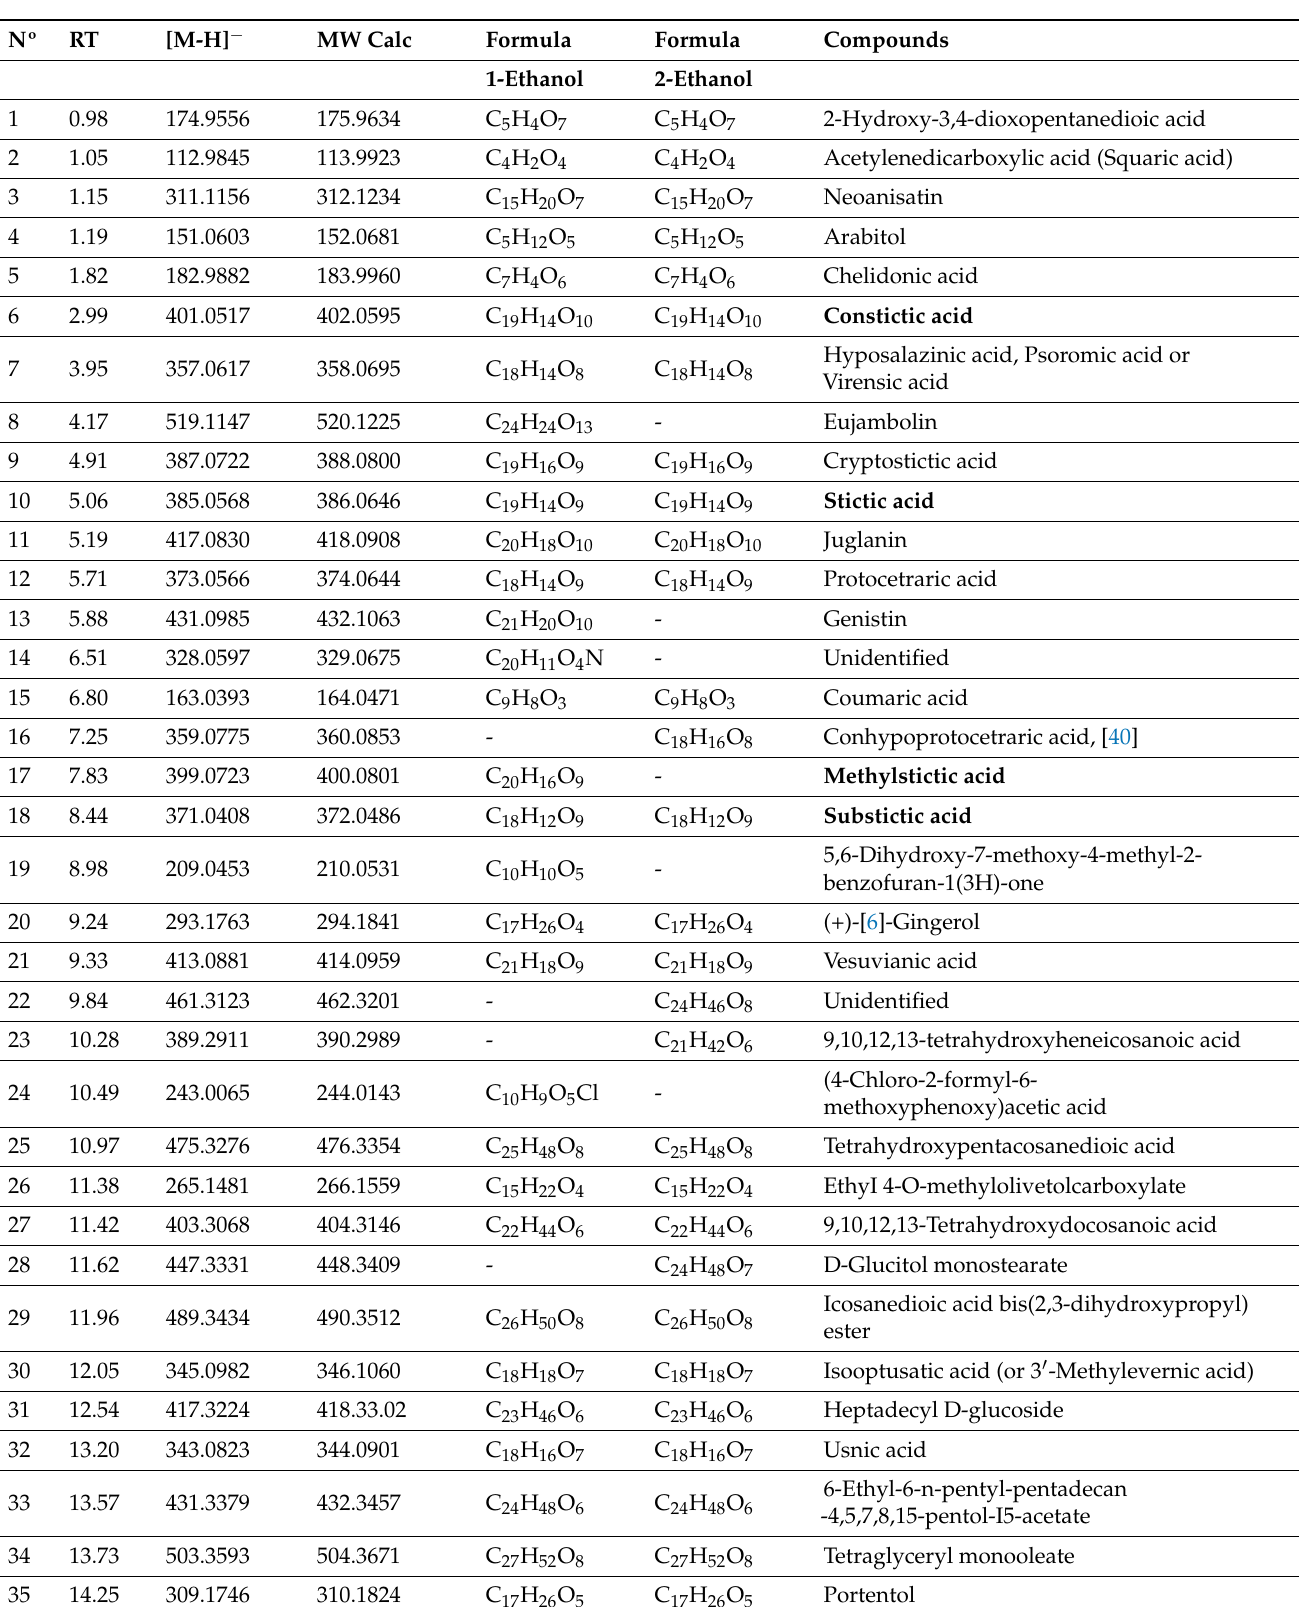
Table 8. Samples Parmotrema hypoleucinum (in Olea europea ), Ethanol extract, 1-Ethanol and